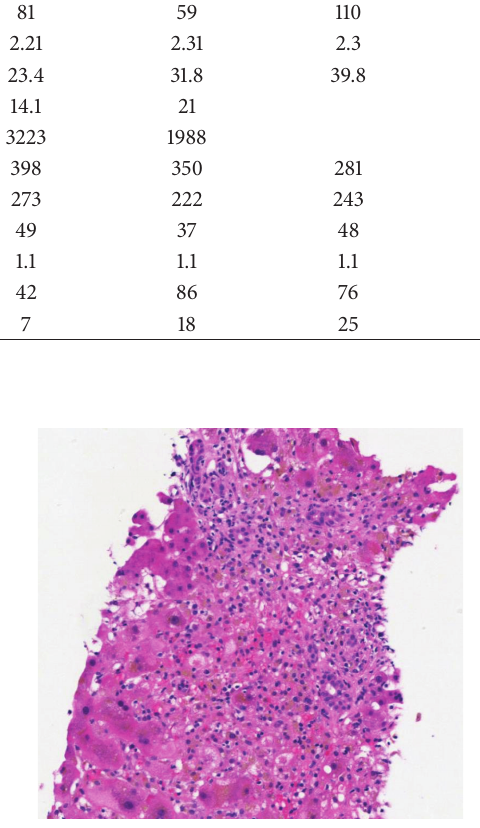
Figure 1: Liver biopsy demonstrating interface hepatitis, cholestasis with brown bile, and hepatocyte